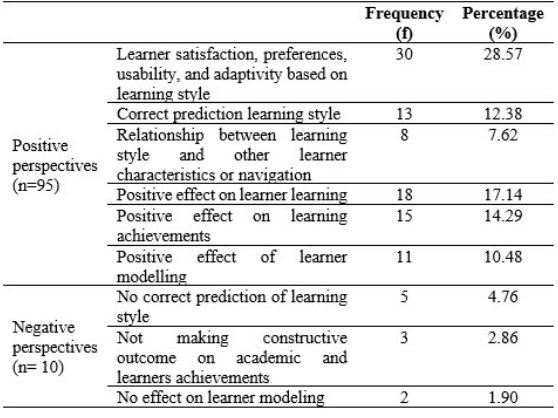
Table 6. Rundown of findings in